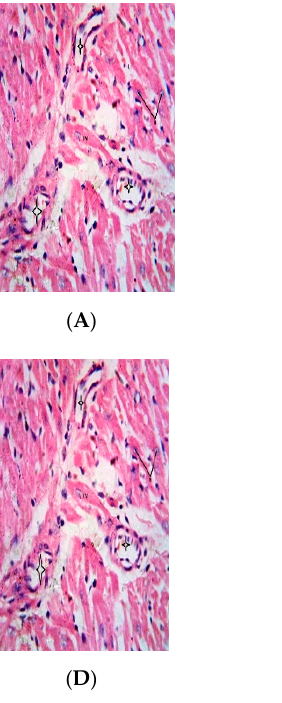
Figure 7: Photomicrograph shows the heart of Wistar rats repeatedly dosed with ( A ) 62.5 mg/kg bw, ( B ) 125 mg/kg bw, ( C ) 250 mg/kg bw, ( D ) 500 µg/kg bw P. dactylifera essential oil and ( E ) control. Cardiac muscle (CM) arranged in bundle, the nucleus (N) and branches of the coronary vessel (star) are normal (×400 H and E Staining).